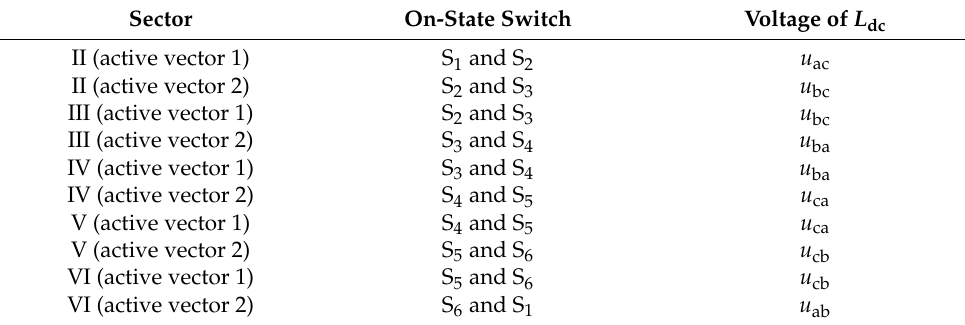
Figure 3. The equivalent circuits of charging and discharging for L dc . ( a ) Equivalent charging circuit; ( b ) equivalent discharging circuit when S 1 and S 6 are turned on; ( c ) equivalent discharging circuit when S 1 and S 2 are turned on.